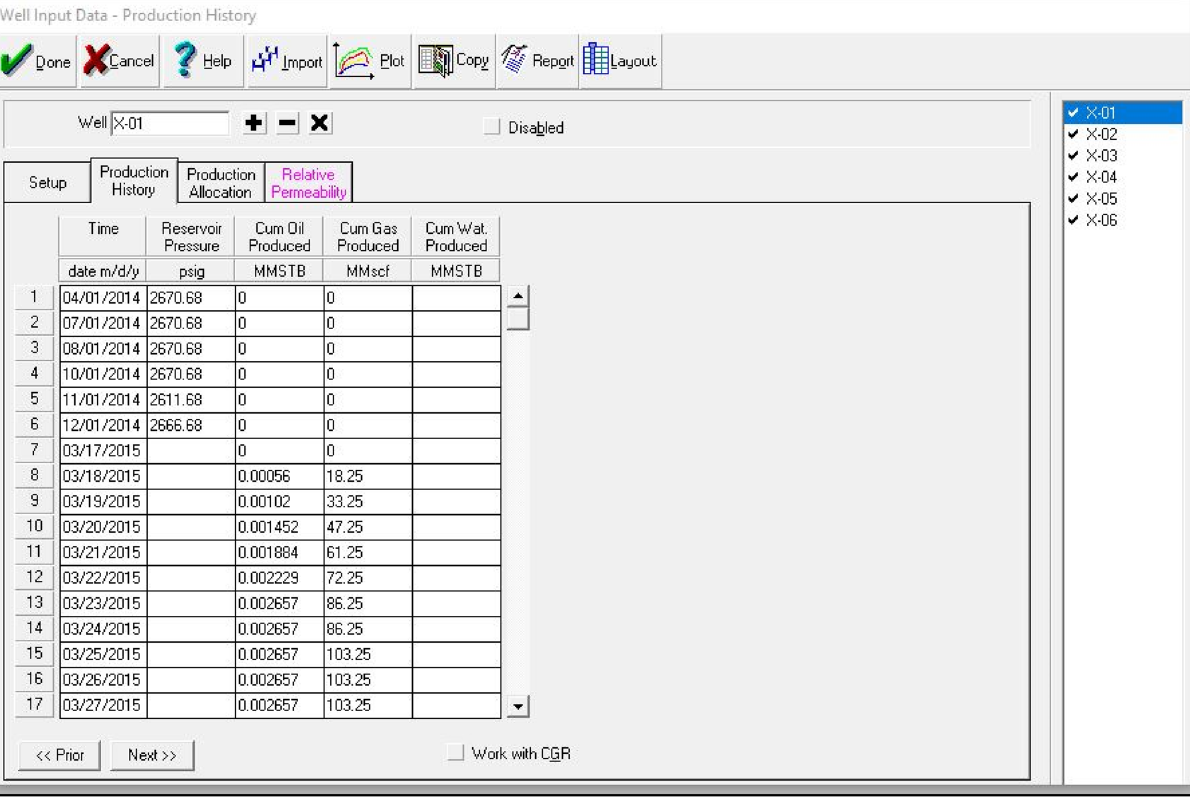
Fig. 10 Material balance model: reservoir